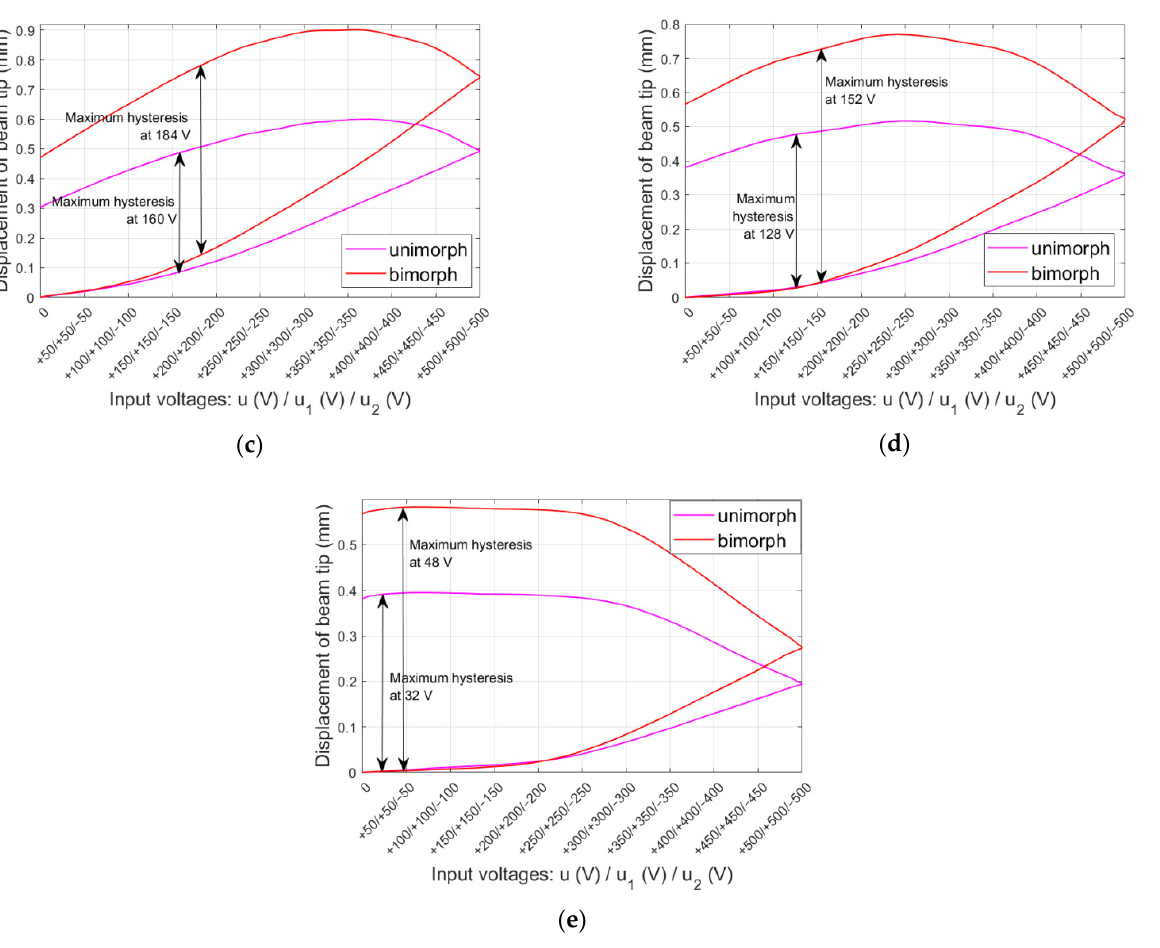
Figure 8. Hysteresis loops in a unimorph and bimorph for u max = +500 V and u 1max = +500 V, u 2max = − 500 V: ( a ) frequency equal to 1 Hz, ( b ) frequency equal to 2 Hz, ( c ) frequency equal to 4 Hz, ( d ) frequency equal to 8 Hz, ( e ) frequency equal to 16 Hz. Comparisons of maximum hystereses for frequencies: 1 Hz, 2 Hz, 4 Hz, 8 Hz, and 16 Hz are presented in Figure 9.